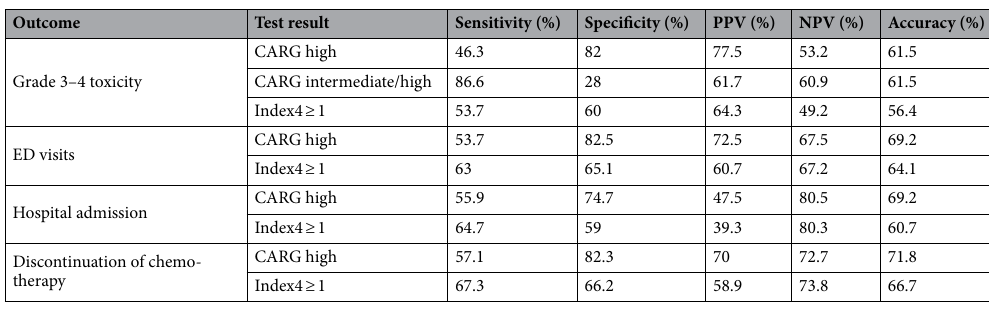
Table 7. Sensitivities, specificities, positive predictive values (PPV), negative predictive values (NPV) and accuracy for prediction of adverse chemotherapy outcomes of the CARG and Index4 tools. ED Emergency Department.